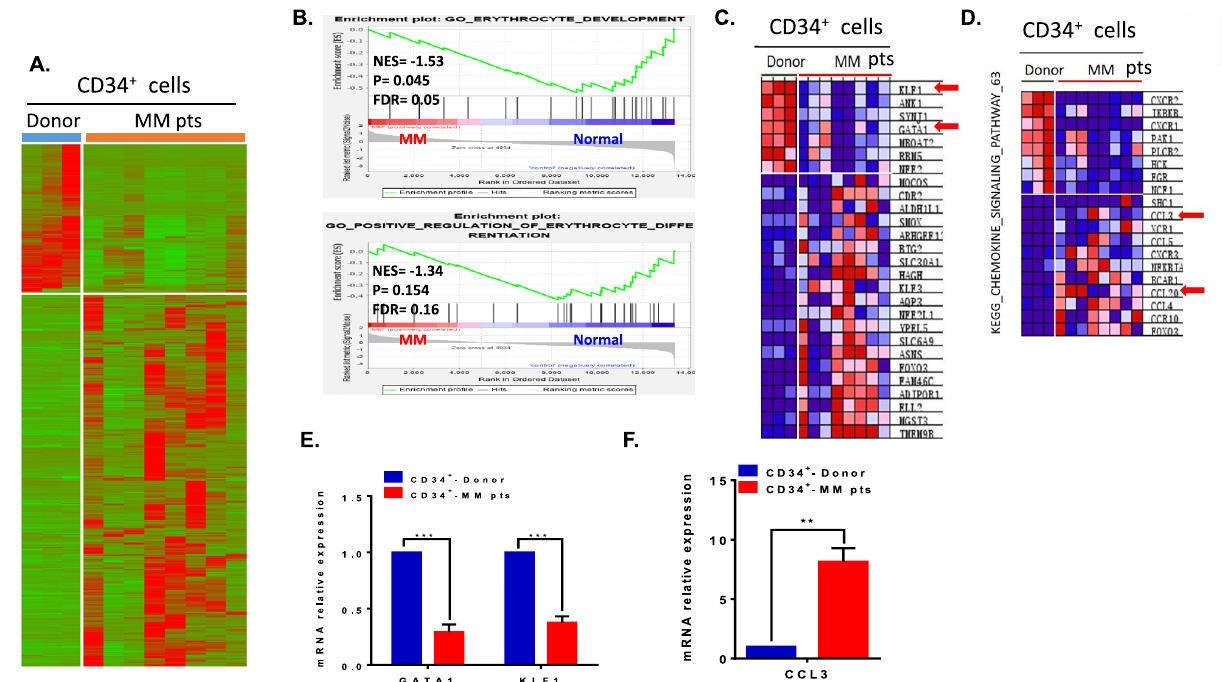
from MM patients and healthy controls. ( B ) GSEA comparison of gene expression inCD34 + cells from